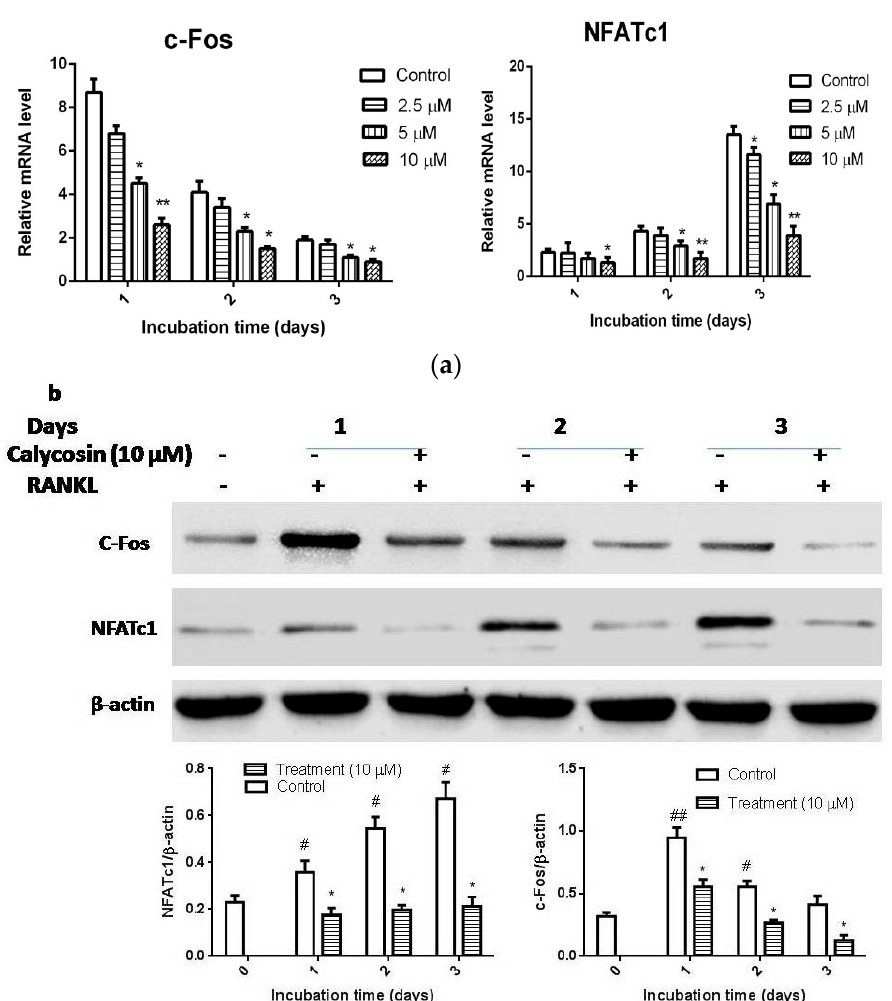
Figure 4. Effects of calycosin on the expression of c-Fos and NFATc1. BMMs were cultured with 20 ng/mL of M-CSF and 20 ng/mL of RANKL in the presence or absence of indicated dose of calycosin for one, two, or three days. ( a ) The mRNA expression levels of c-Fos and NFATc1 were examined by quantitative real-time PCR; and ( b ) the protein levels of c-Fos and NFATc1 were examined by western blot. The relative quantification of target proteins was calculated by comparison of the bands density levels between samples. The results were expressed as means ± SD from three independent experiments. * p < 0.05 vs. control. # p < 0.05 and ## p < 0.01 vs. vehicle-treated group.